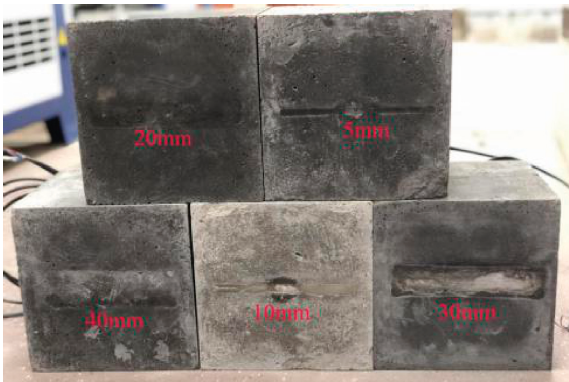
Figure 10: Different thickness models.